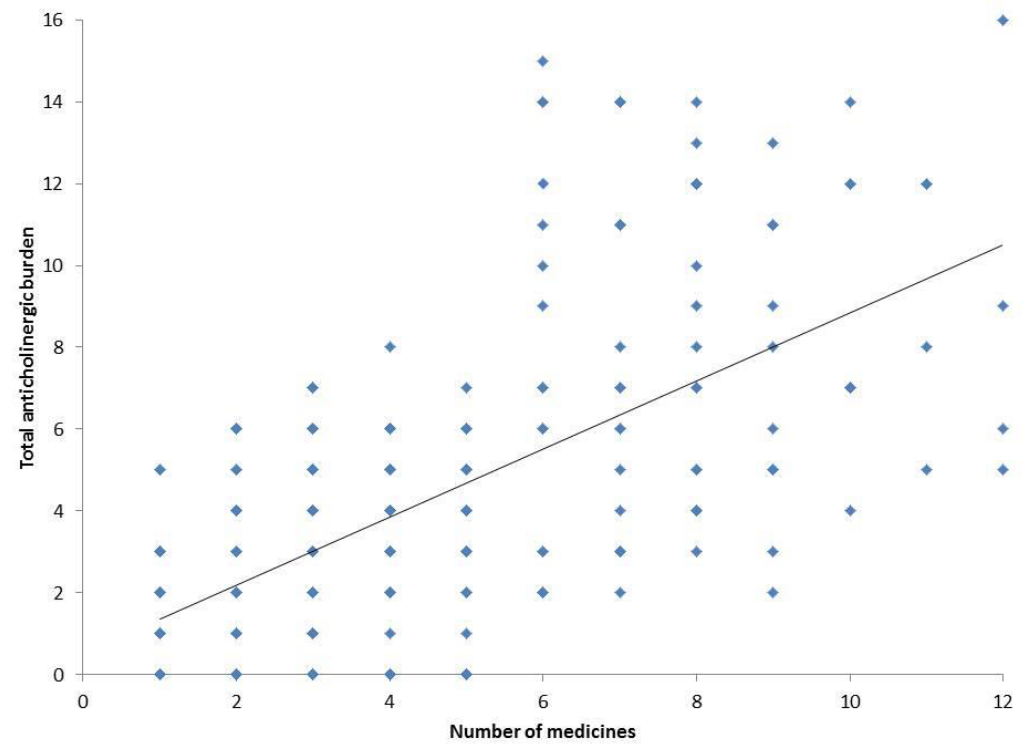
Figure 1. Correlation between the total number of medicines taken and total anticholinergic burden in the study population. Each dot represents the data of individual patients ( n = 305).